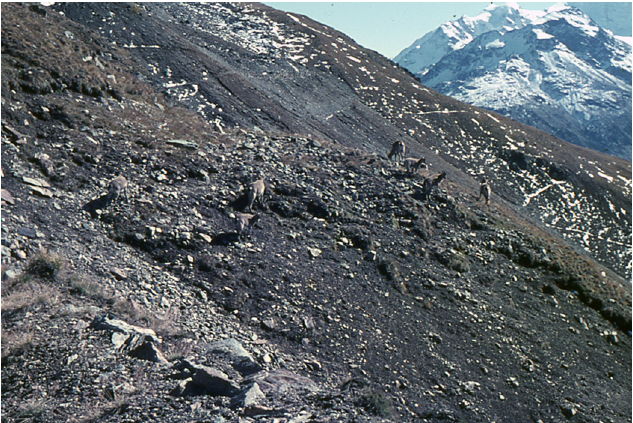
Fig. 12: Soil erosion on the mountain above Pontresina village at about 2600 m. Several ibex are in the middle of the picture. Establishment of trees as a result of climatic warming is unlikely in such sites (see also Fig. 13). Photo taken by the author, 8 October 1967.